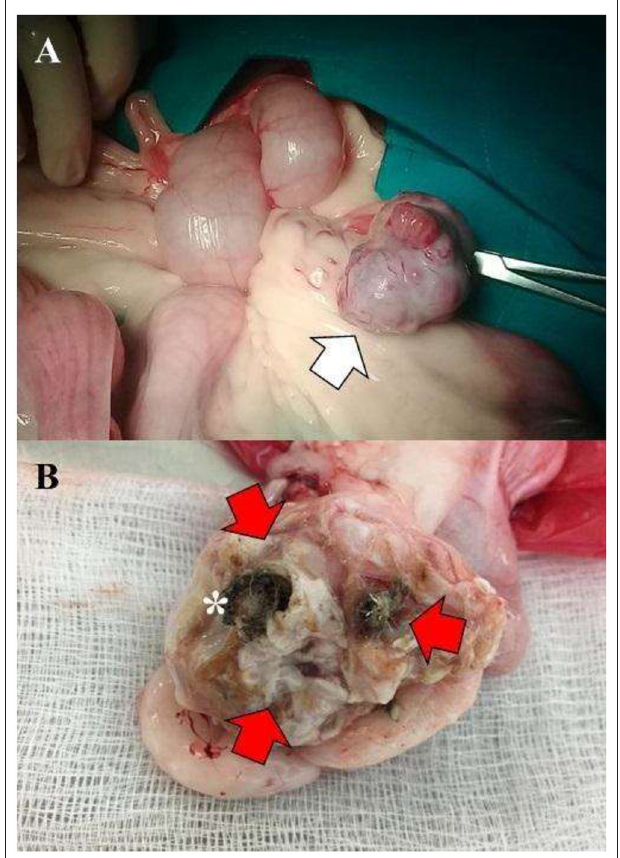
FIGURE 2 | (A) Polycystic left ovary with evidently increased size (3.0 × 2.5cm) (White arrow). (B) Right ovary exhibiting hair, cartilage (Red arrows), and bone tissue